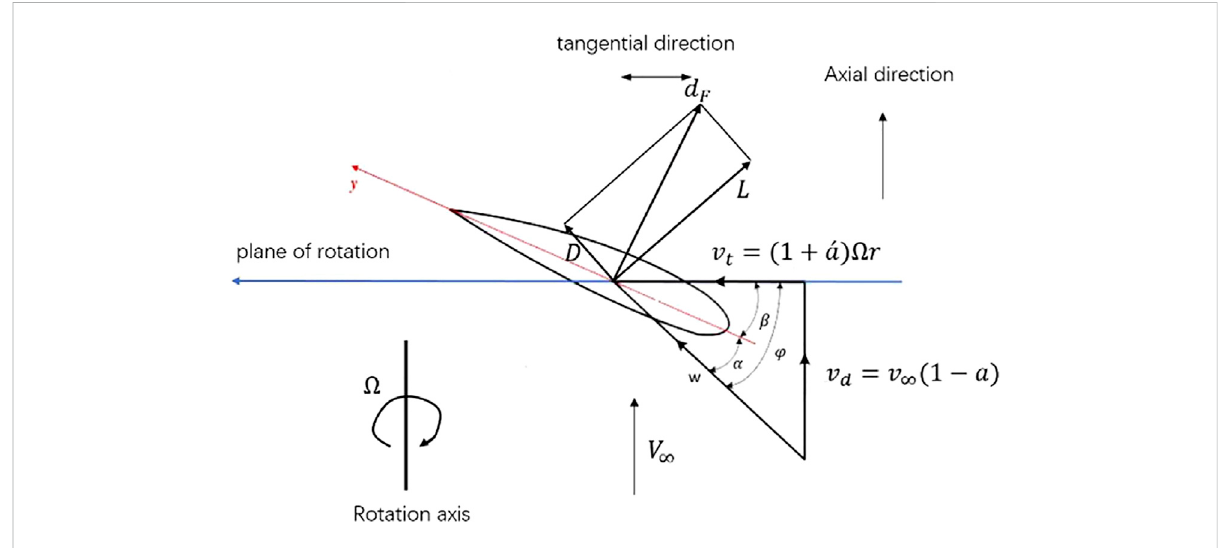
FIGURE 1 Blade element velocity triangles and force vector